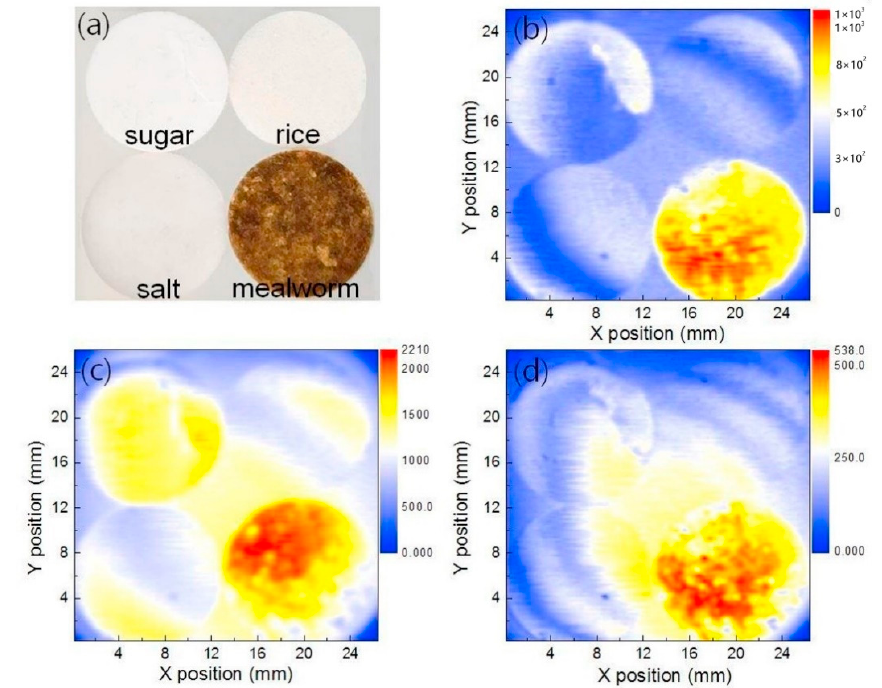
Figure 6. ( a ) The optical image of rice, sugar, salt, and mealworm pellet samples and their reflective THz images at THz frequency of ( b ) 1 THz, ( c ) 0.5 THz, and ( d ) 1.2 THz. (Reprinted/Adapted) with permission from [93] © 2017, Elsevier Ltd..